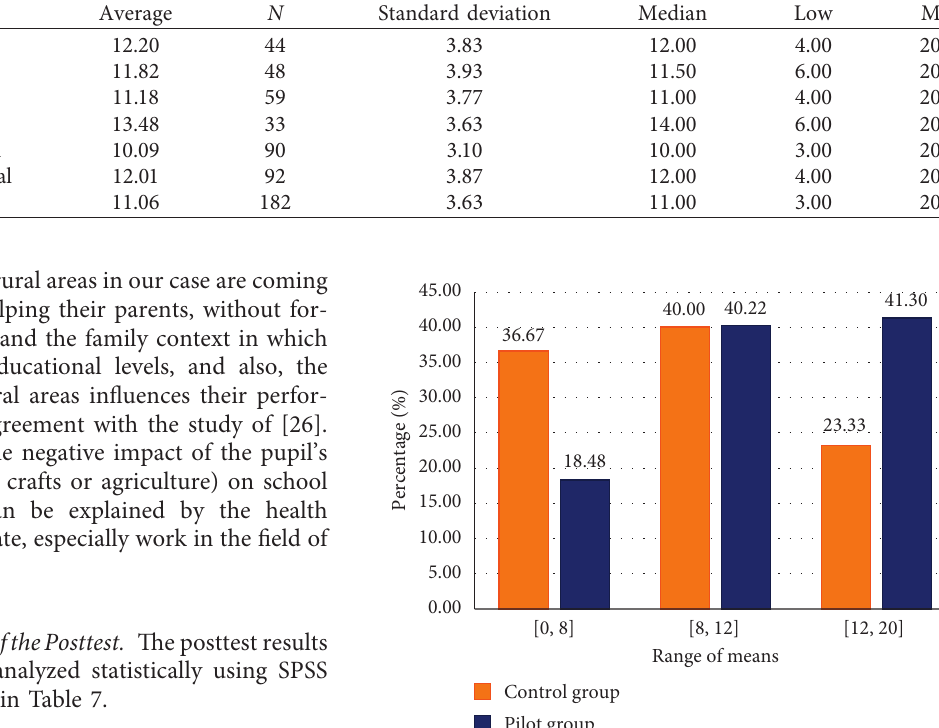
Table 7: Means of the evaluation test according to the gender (pilot), area (pilot), and method used. Average